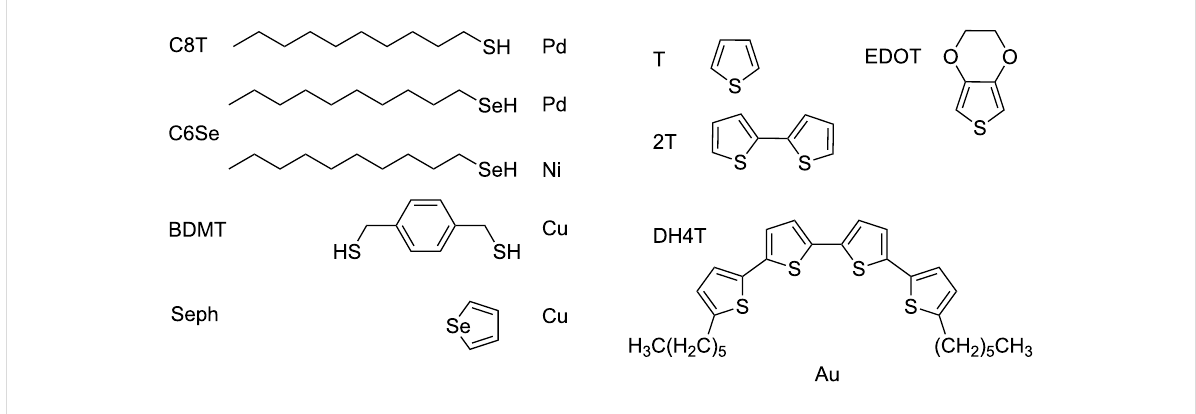
Figure 1: The main molecule–metal combinations discussed in this report: alkane chalcogenides (CnT), 1,4-benzenedimethanethiol (BDMT), selenophene (Seph), 3,4-ethylenedioxythiophene (EDOT), thiophene (T), bithiophene (2T), and α , ω -dihexylquaterthiophene (DH4T). Other examples of EDOT family compounds are mentioned